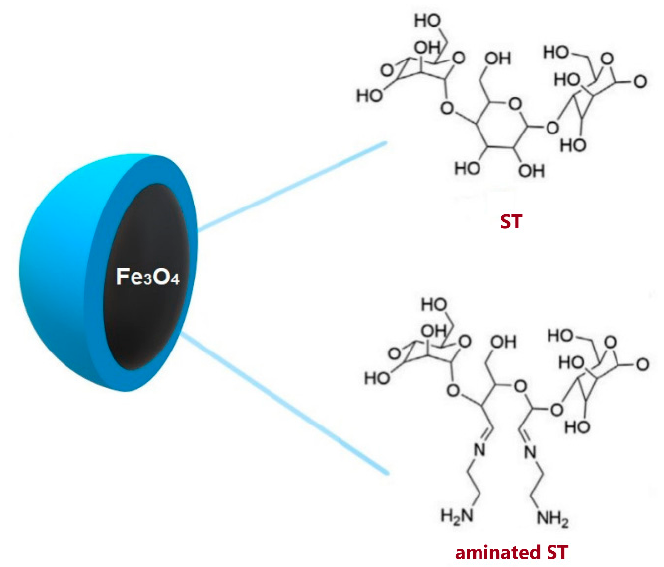
Figure 9. Magnetite nanoparticles coated with ST and aminated ST. Reprinted from [149], Interna- tional Journal of Molecular Sciences 2021.